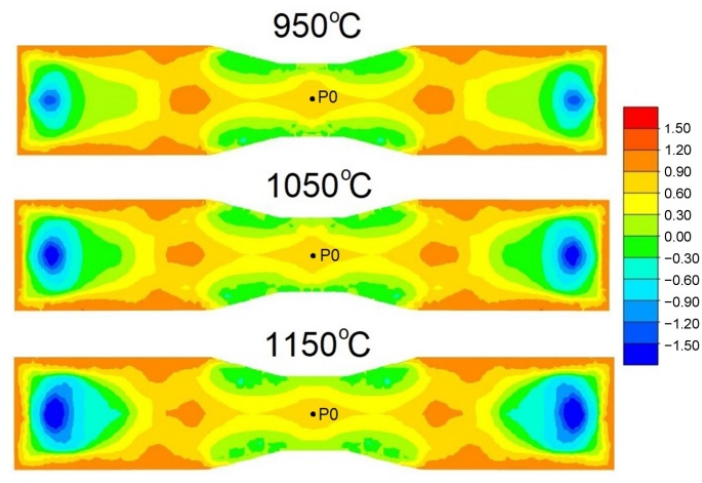
Figure 7. Distribution of the stress ‐ state indicator values σ 1 / σ i .